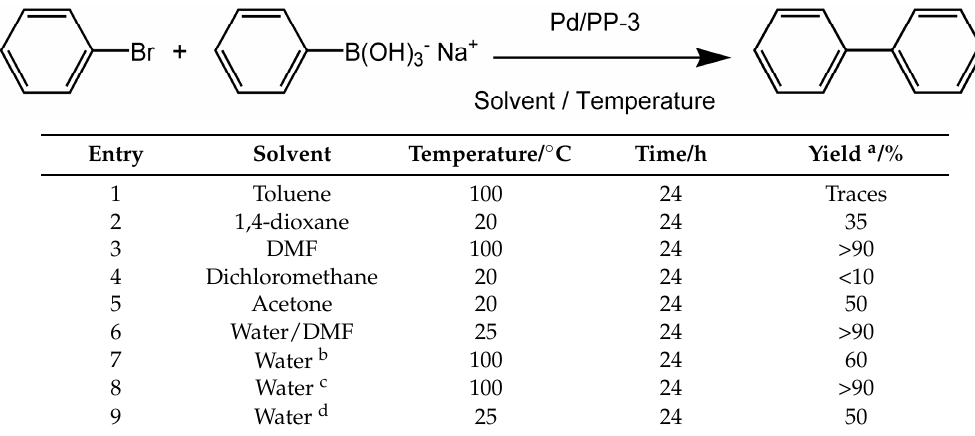
Table 1. Optimization in reaction conditions for Suzuki coupling reactions between 1 equiv